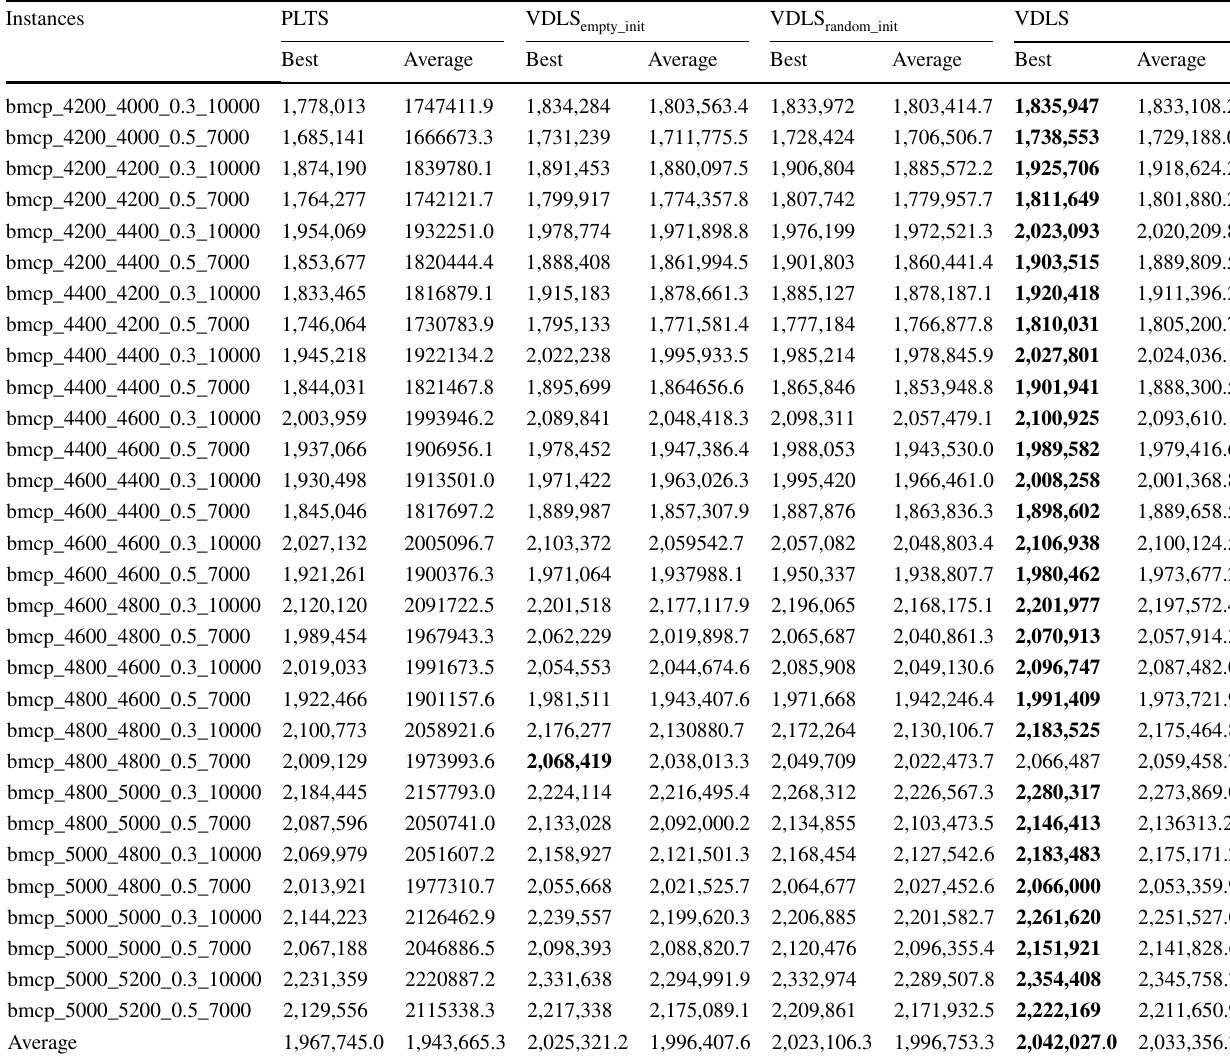
Table 11 Comparison of the VDLS and its variant algorithms, VDLS empty_init and VDLS random_init , as well as the PLTS algorithm, with 30 min of time limit in solving the 30 instances of the third set